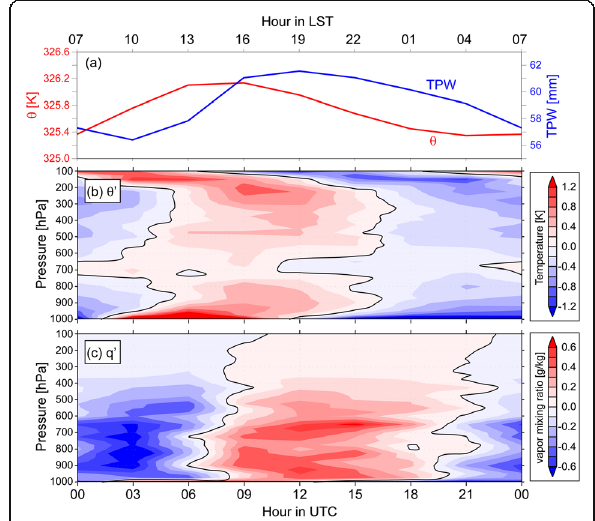
Fig. 8 Diurnal composite of potential temperature and moisture. a Potential temperature averaged for troposphere (red) and precipitable water (blue). Time – height cross section for b potential temperature and c moisture, as the anomalies from the 1-day running mean at each pressure